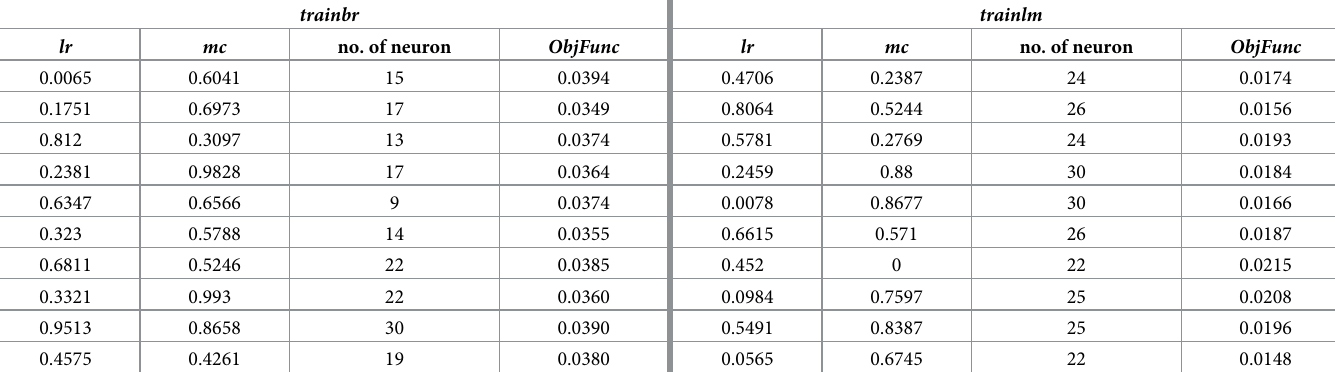
Table 2. Robustness of trainbr and trainlm algorithms.